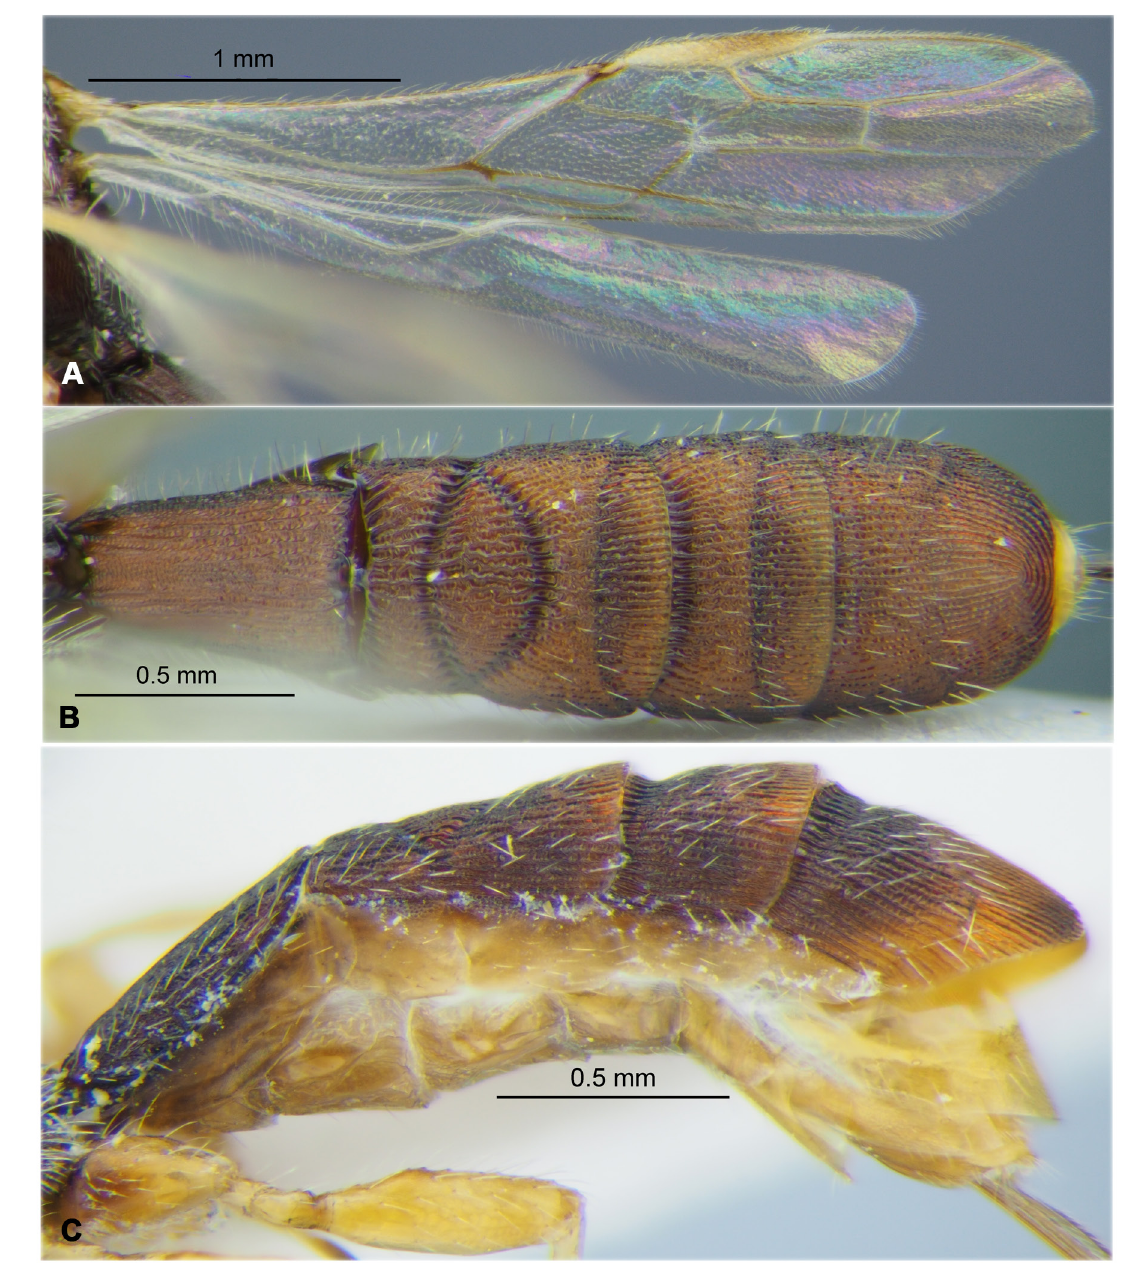
Fig. 56. Rhaconotus (Rh.) microexcavatus Belokobylskij sp. nov., holotype, ♀ (RMNH). A . Wings. B . Metasoma, dorsal view. C . Metasoma, lateral